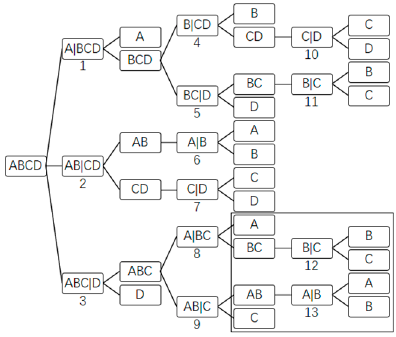
Figure 9. The solution space of the petroleum refinery case (the nodes enclosed in frame are pruned).